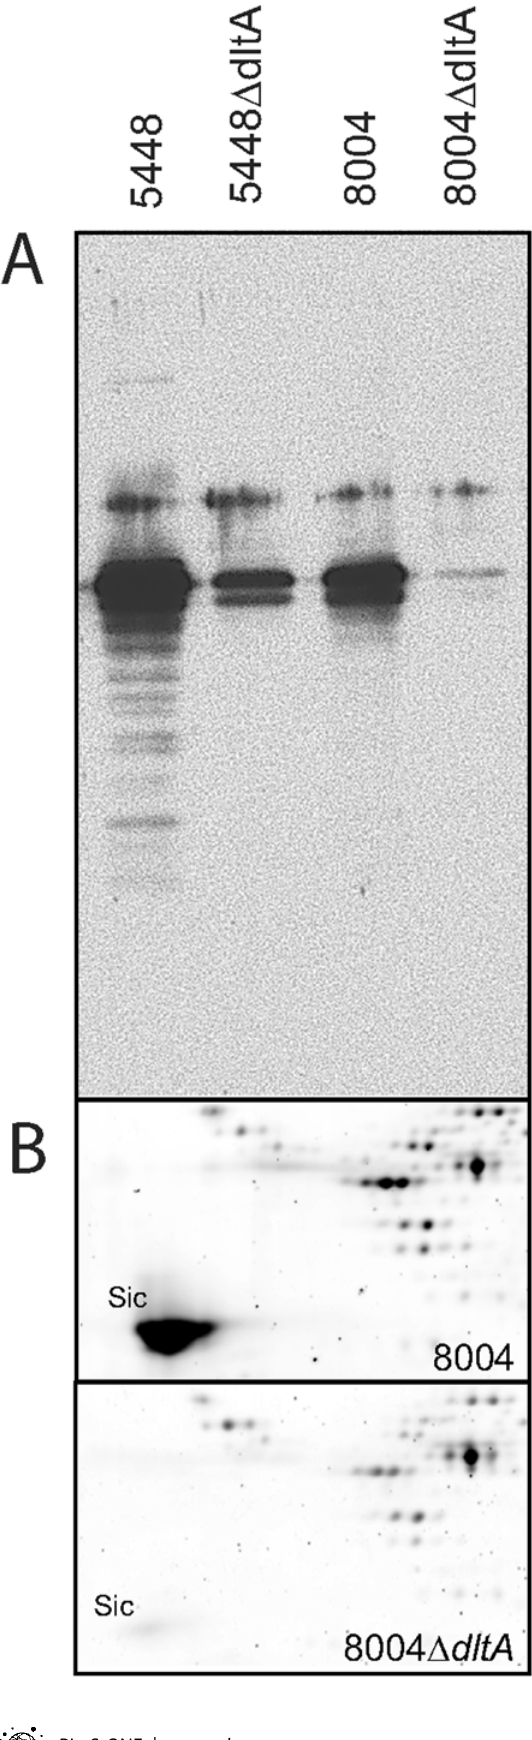
Figure 7. Analysis of the amounts of M protein and SIC released into the medium. Protein was precipitated from the supernatant of WT and dltA mutant bacteria grown to mid-log phase using TCA. A) Samples were separated by SDS-PAGE and blotted to nitrocellulose. Bands containing M1 protein were visualized using an anti-M1 antibody. B) Samples from 8004 and 8004 D dltA were separated by 2-D gel electrophoresis. Only the portion of the gel surrounding SIC is shown. SIC was identified by mass